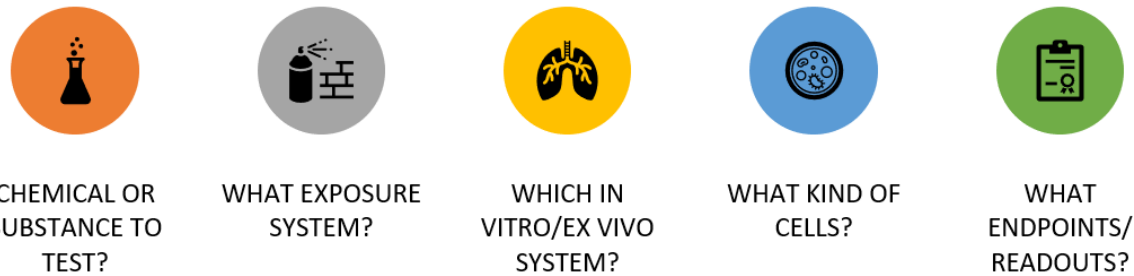
Figure 7. Questions influencing the INSPiRE Initiative study design (Part of NAM-04 presentation, Supplemental File). Table 2. Advantages and disadvantages of certain inhalation test systems. (Part of NAM-04 presen- tation, Supplemental file).